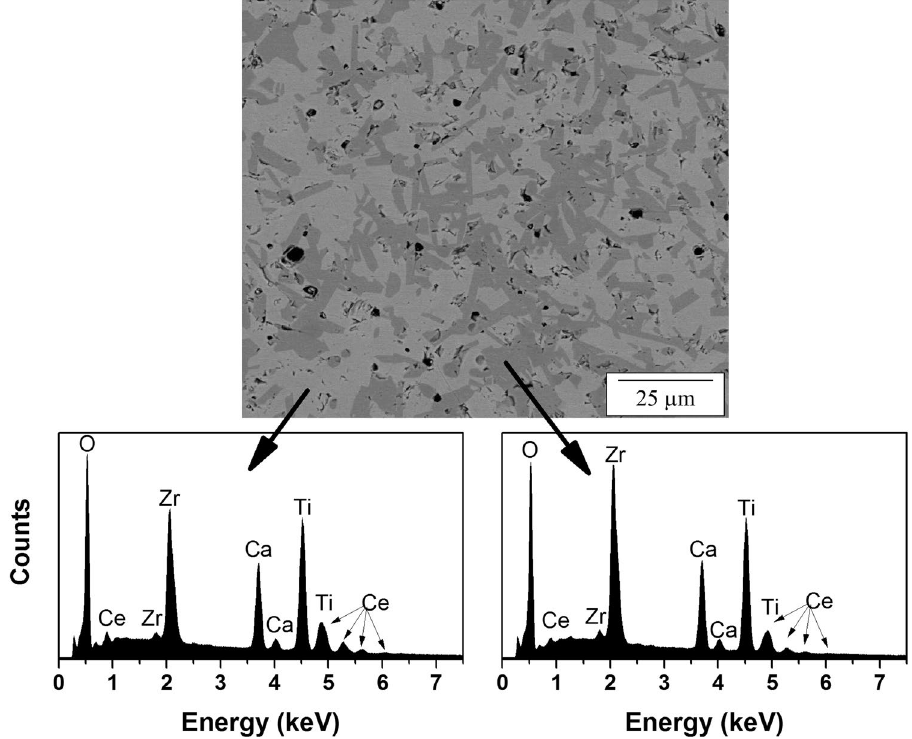
Figure 3. Representative BSE image of synthesized CaZr 0.7 Ce 0.3 Ti 2 O 7 and corresponding EDS spectra from the two phases seen.